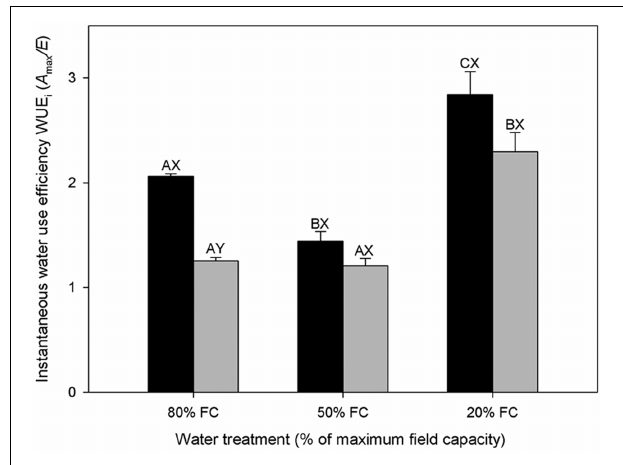
FIGURE 2 | Instantaneous water use efficiency (WUE i ) of diploids (black bars) and hexaploids (gray bars) under different soil water conditions (80% of maximal FC, 50% FC, 20% FC). Each value is presented as mean ± SE. Letters distinguish between statistically separable ( p < 0.05) values for different water treatments (A, B, C) and for different cytotypes (X, Y).